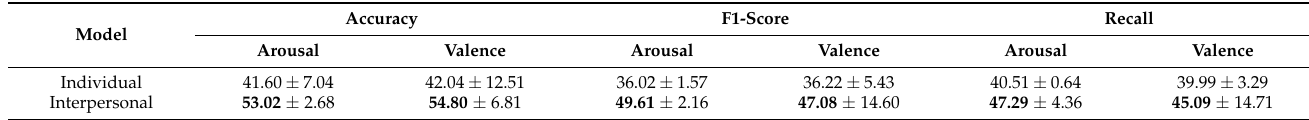
Table 4. The main experiment result for audio modality.